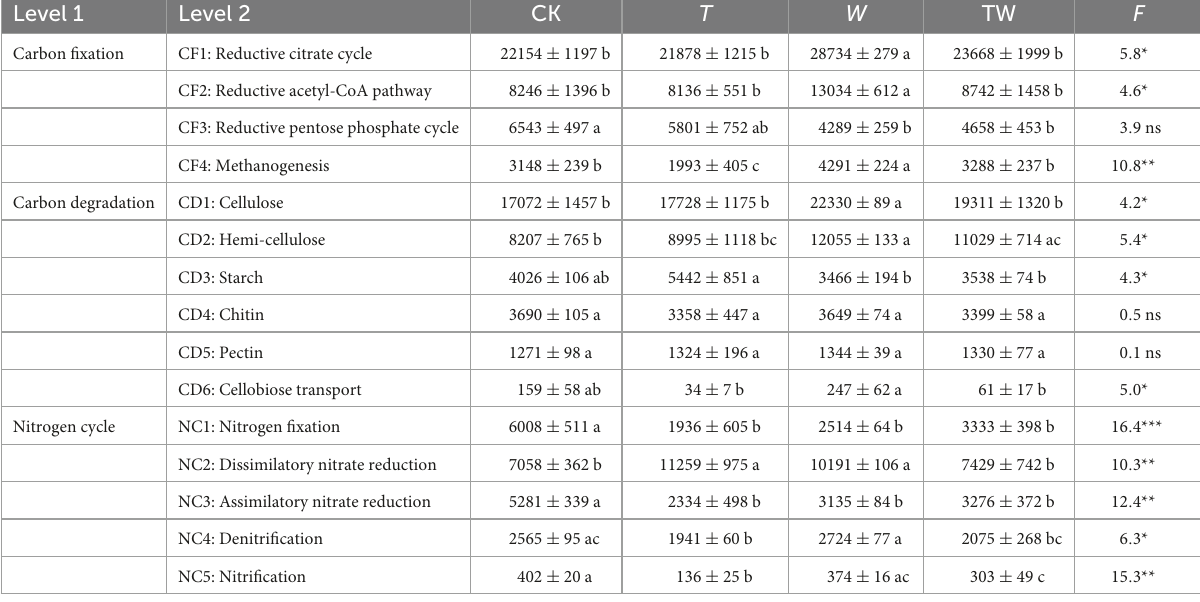
TABLE 2 Soil microbial functional genes associated with carbon and nitrogen cycle in different global change treatments.